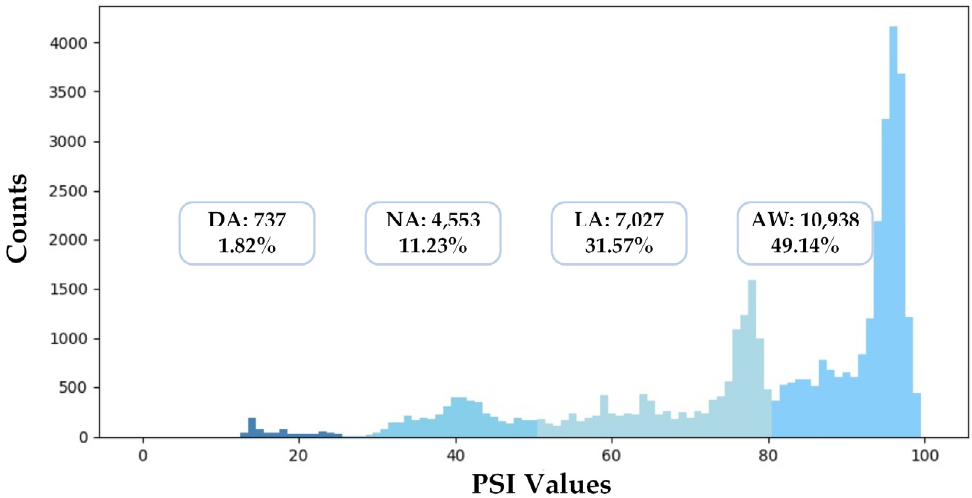
Figure 7. The data distribution of the dataset used in this study. Each EEG sample contains 4 channels of 4 s EEG signals whose dimension is 4 ×